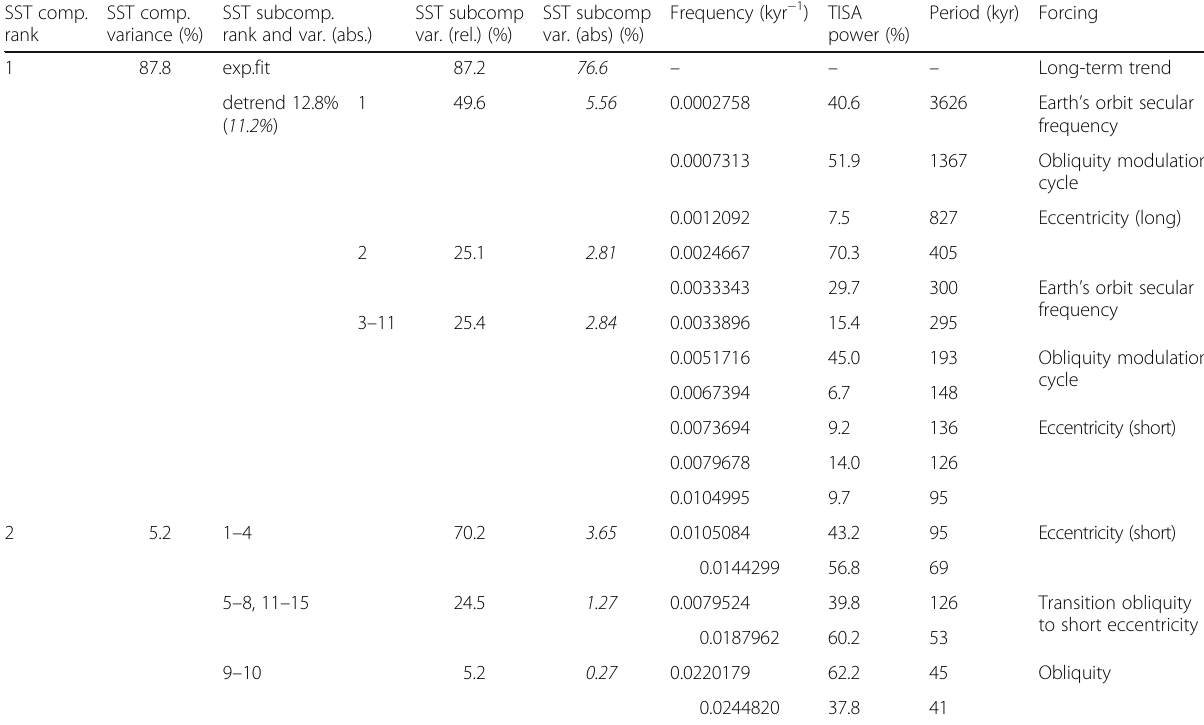
Table 6 Main descriptive parameters and Fourier frequency results of the ODP Site 846 SST subcomponents isolated from the detrended comp-1 and comp-2 by singular spectrum analysis. The processing of the subcomponents was made in order to better separate and estimate the variance fraction of specific frequency bands from still complex data components. The italicized percentage numbers are the absolute variance of the subcomponents (referred to the total SST variance) SST comp.